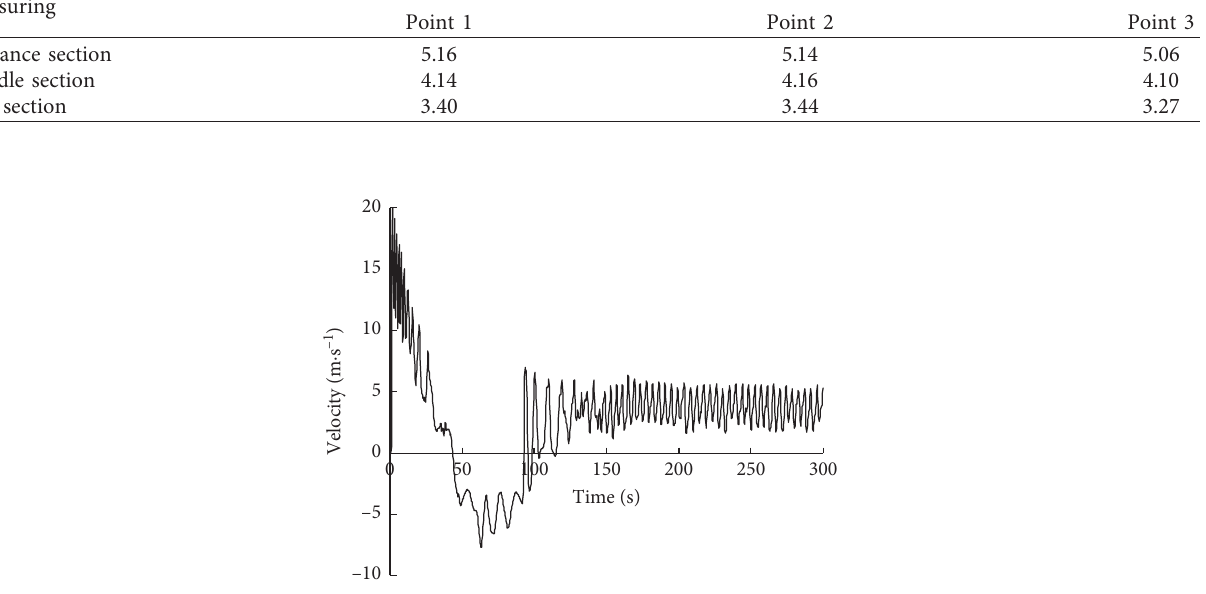
Figure 13: Variation of flow velocity in the middle of cross channel when the stable low-speed opposite flow appears in the non-fire tunnel.